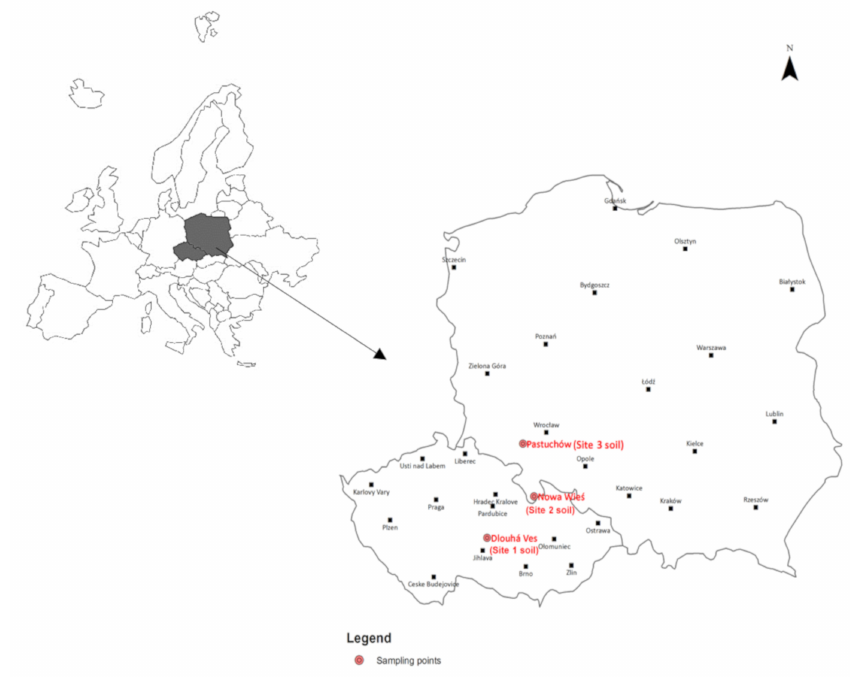
Figure 1. Soil collection locations in the research